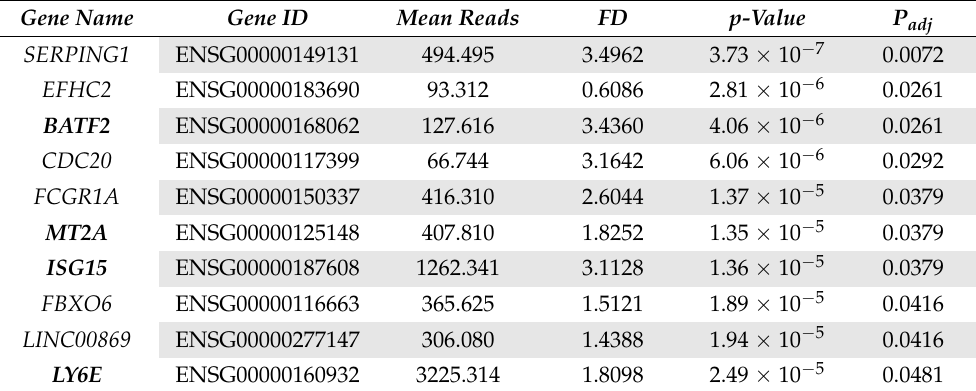
Table 2. Top transcripts showing differential expression in whole blood RNA sequencing. RNA- seq reads are shown for children with autism spectrum disorder (ASD; N = 8) vs. neurotypically developing children (control; N = 9) with adjusted Padj < 0.05. Padj and p .-values were obtained using DESeq2 (see Methods). The genes are arranged by increasing adjusted p values (P adj ). FD, fold difference (ASD vs. controls). Gene names in bold fonts indicate the genes validated as dysregulated by real-time qPCR in the combined Israeli and American